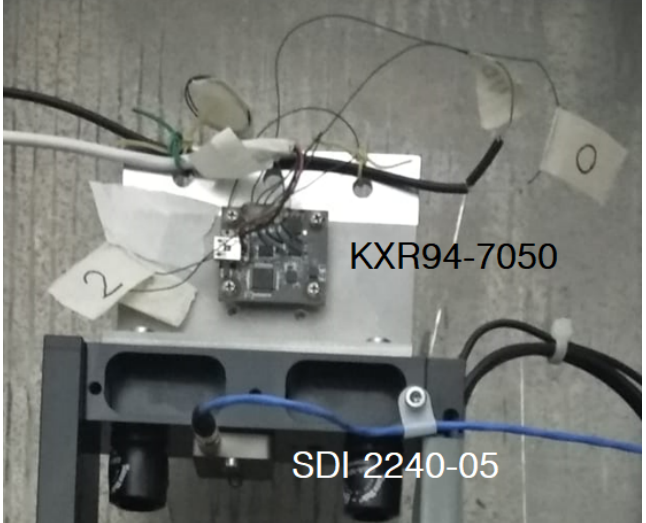
Figure 4. The figure shows the tightening of two sensors in detail; SDI 2240-05 is a sensor (a